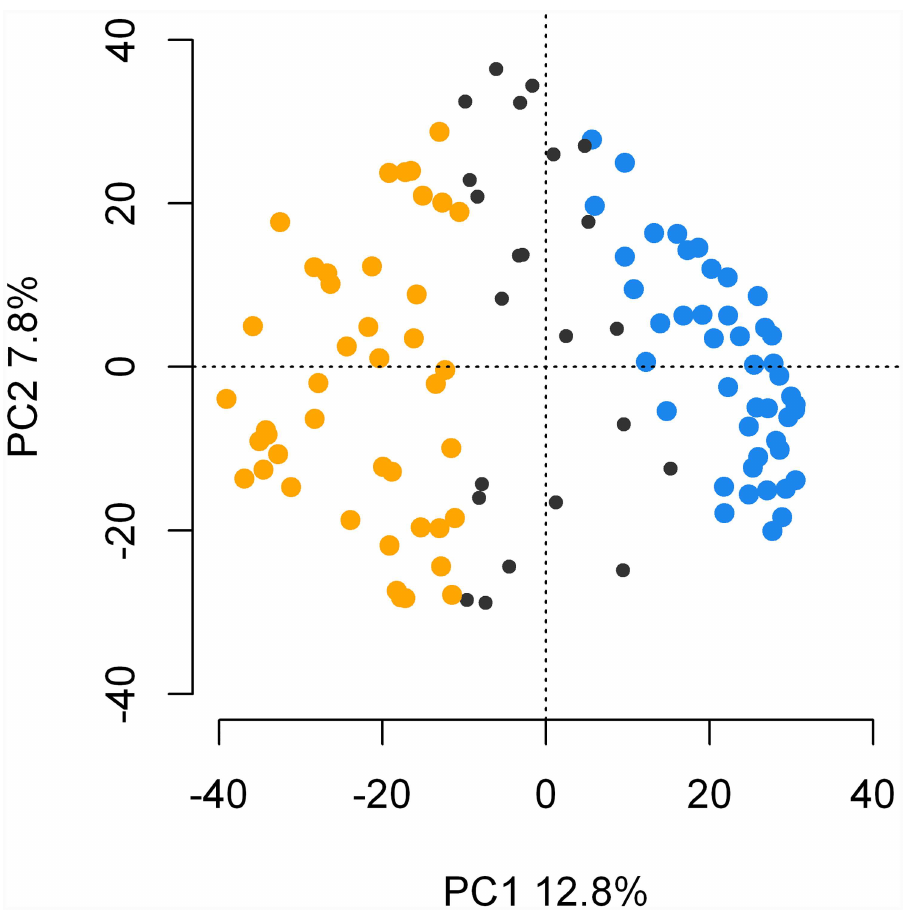
Fig 1. Population structure analysis. Scores plot of PC1 vs. PC2 from PCA on the markers analyzed.Blue and yellow colors correspondto 6-row and 2-row groups respectively as assignedbasedon results from STRUCTURE. Branches and closed circles in black color correspondto genotypesnot uniquelyassignedto a group.